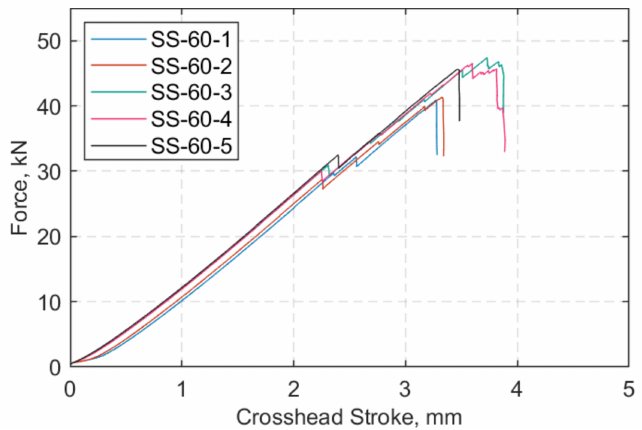
Figure 14. Force (kN) vs. crosshead stroke (mm) at 60 ◦